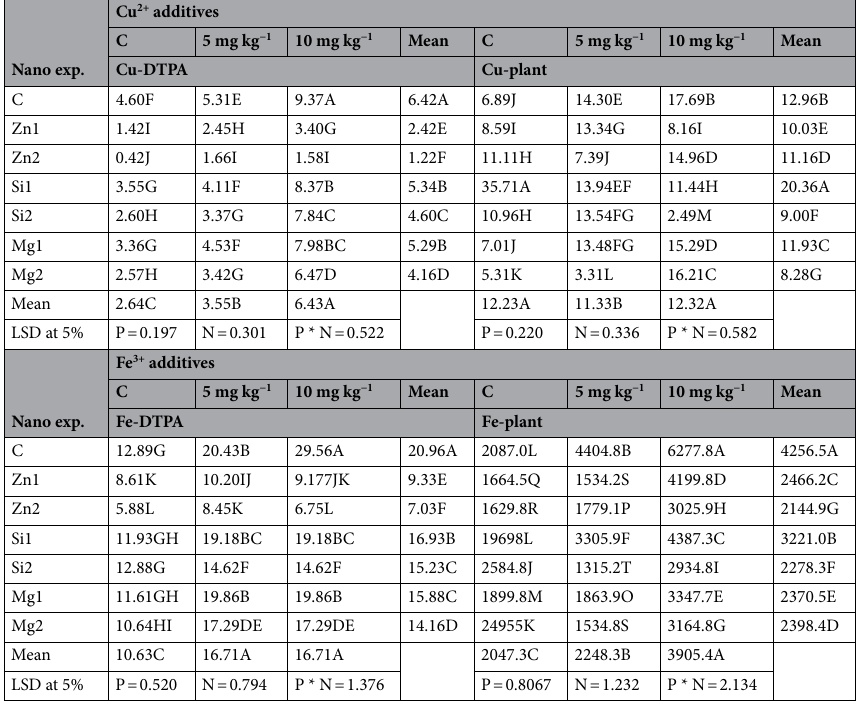
Table 4. Effect of different NPs and polluted water containing Cu 2+ and Fe 3+ on the availability of Cu 2+ and Fe 3+ in soil and